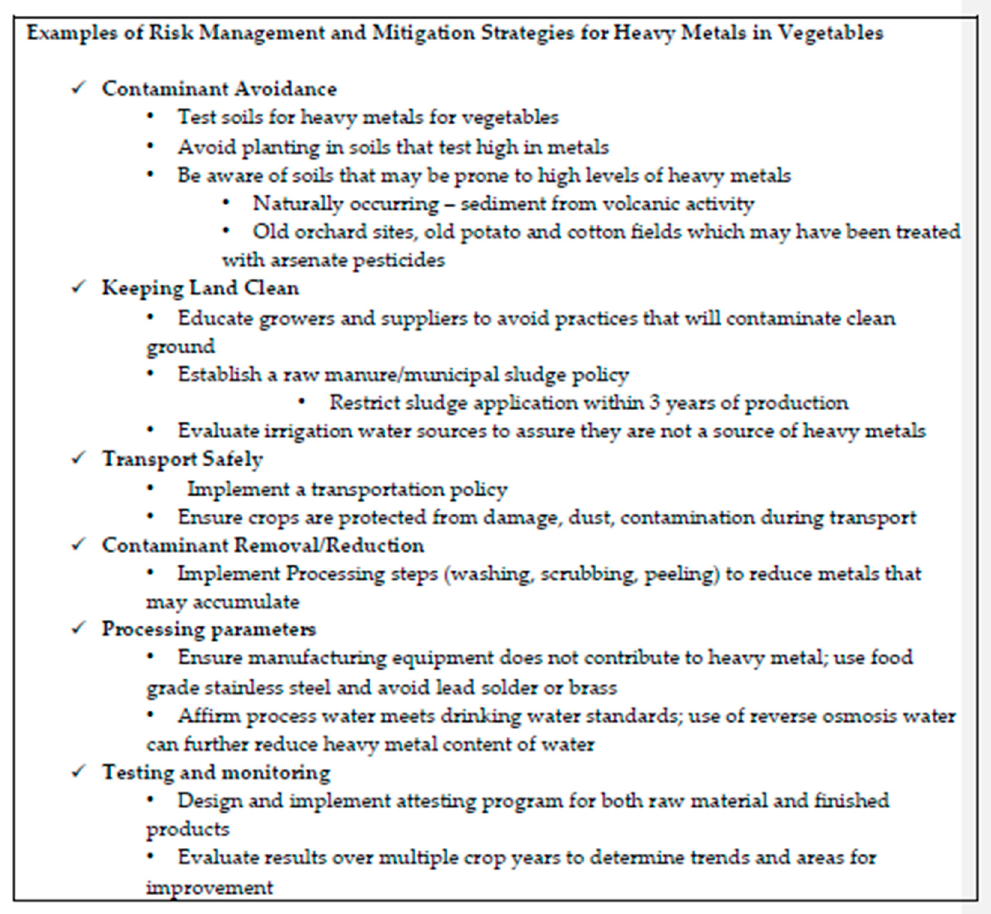
Figure 1. Practices Used to Control Heavy Metals in Baby Food Vegetables.